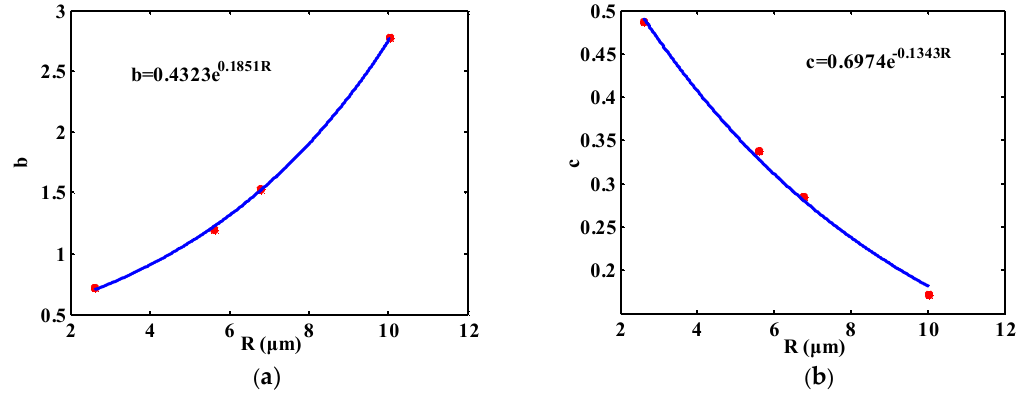
Figure 6. Parameters ( b and c ) versus radius: ( a ) b ; ( b ) c .